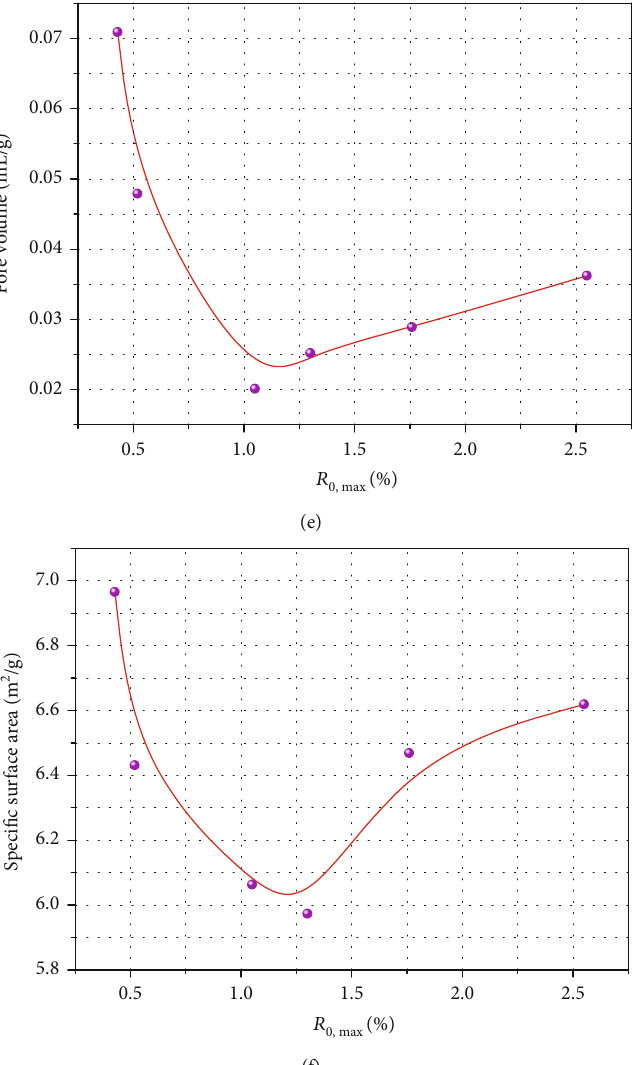
Figure 5: Results of the high-pressure mercury injection experiment. (a) Pore volume distribution; (b) pore volume proportion; (c) pore speci fi c surface area distribution; (d) pore speci fi c surface area proportion; (e) shows the relationship between total pore volume and metamorphic degree; (f) shows the relationship between total speci fi c surface area and metamorphic degree.